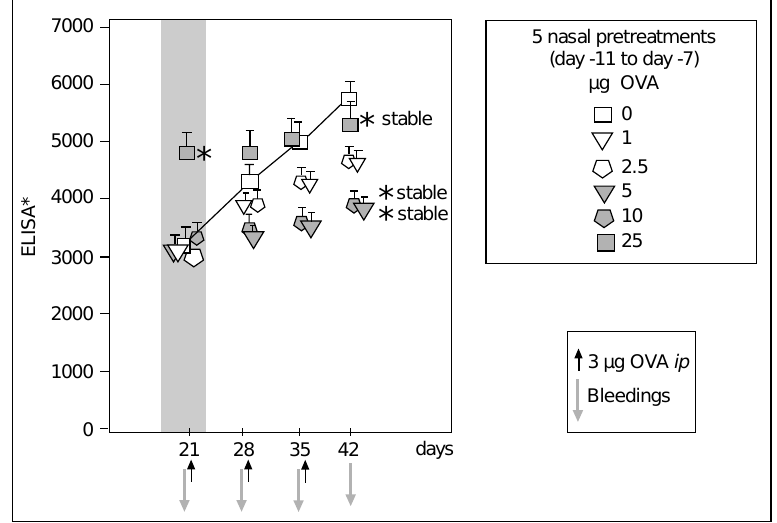
Figure 6 - Stabilization of serum antibody responses in the ab- sence of oral tolerance in senile mice. Seventy-week-old B6D2F1 mice were pretreated with one gavage of either saline (open squares) or saline containing 20 mg OVA (filled squares) 7 days before primary immunization with 10 µg OVA + 1 mg Al(OH) 3 ip ; 14 days later, a series of 4 weekly challenges with 3 µg soluble OVA was initiated. Im- mediately before each booster the mice were bled for meas- 3 µg OVA urement of antibodies by ELISA. Asterisks indicate significant dif- ferences between control and experimental